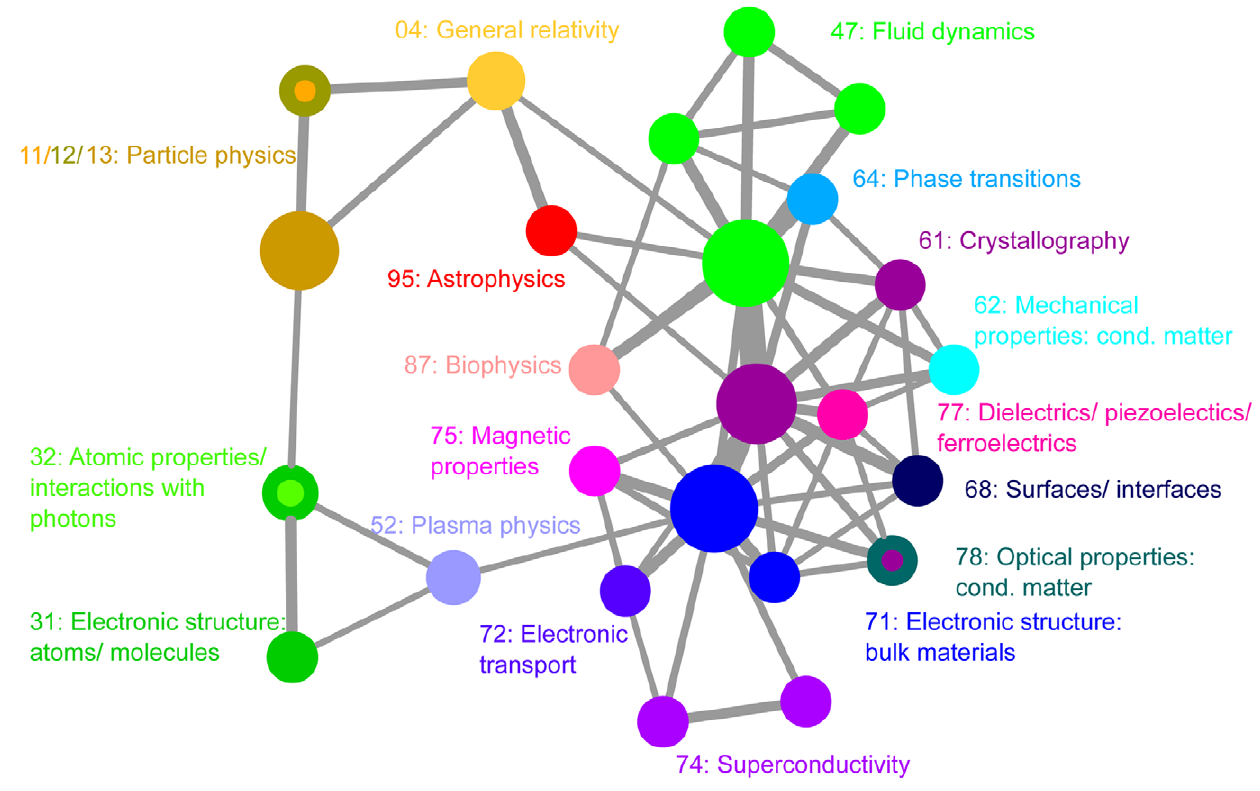
Figure 3. The scientific concept network for the first half of 2005.